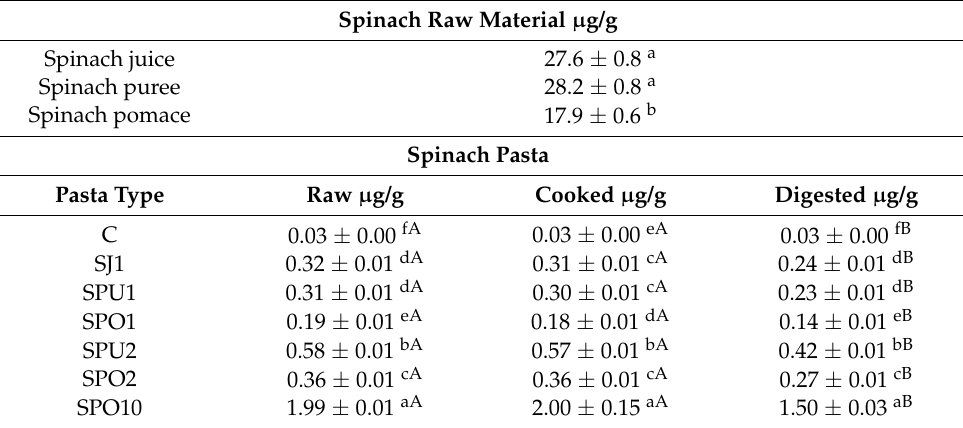
Table 5. β -carotene content of spinach raw material and